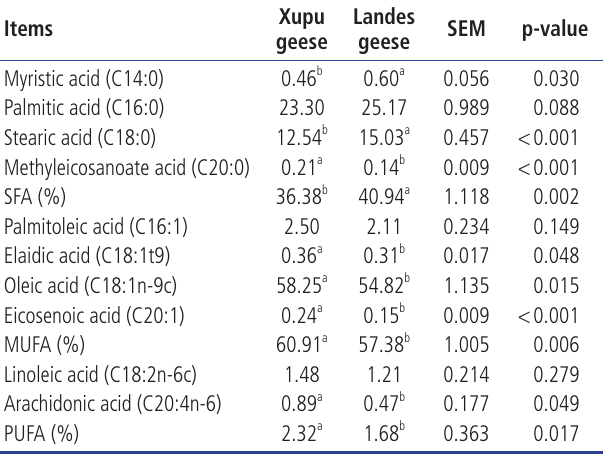
Table 4. Comparison of fatty acid composition between overfed Xupu and Landes geese